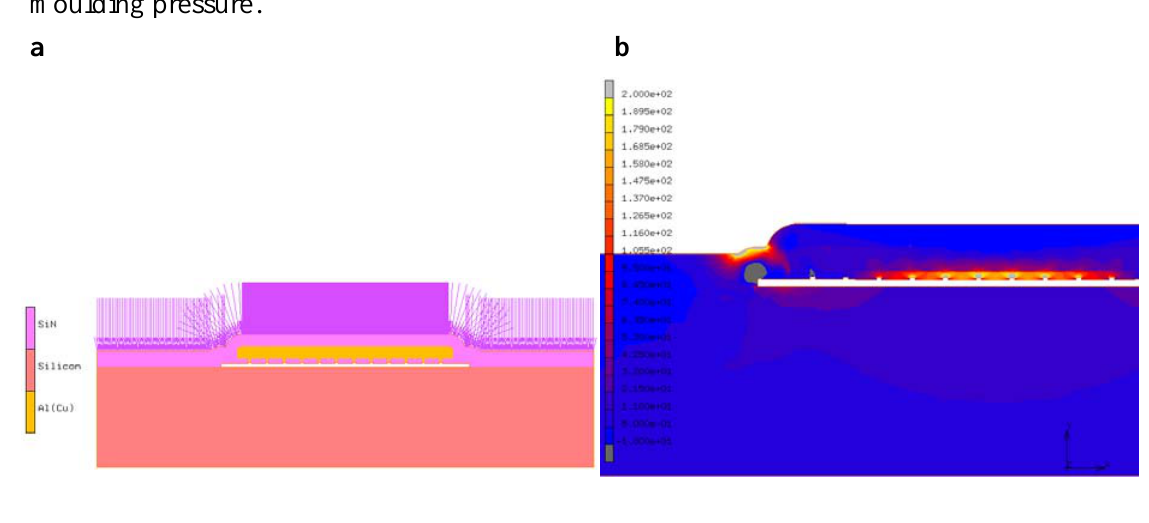
Figure 14. (a) Model of the WLTFP under moulding pressure (arrows represent the moulding pressure); (b) The maximum principal stress in the WLTFP due to an 80 bar moulding